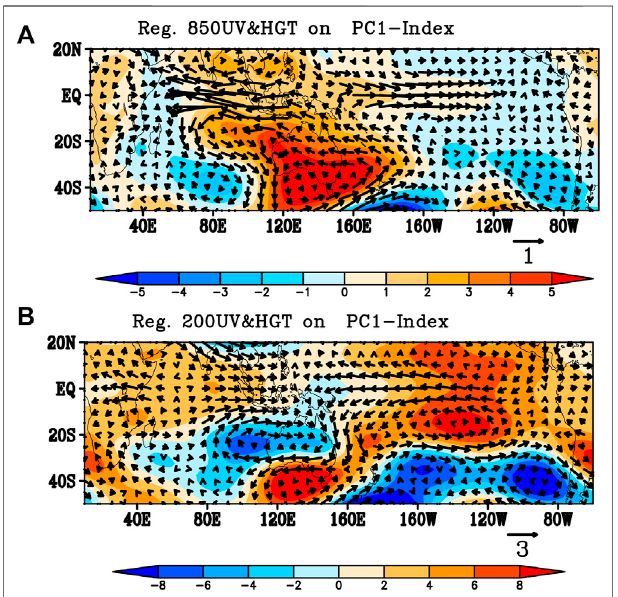
FIGURE 4 | Regressions of (A) 850 hPa horizontal winds (vectors; m s − 1 ) and geopotential height (shading; m), (B) 200 hPa horizontal winds (vectors; m s − 1 ), and geopotential height (shading; m) against the PC1 during OND season for 1950 – 2017.